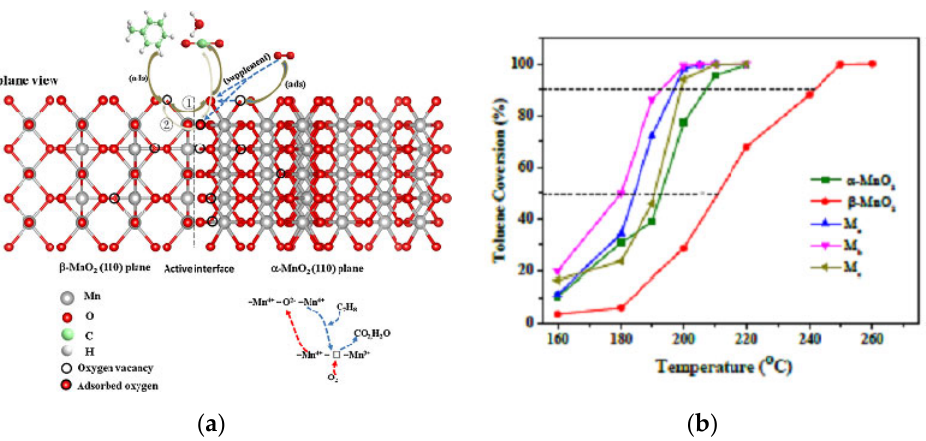
Figure 12. ( a ) Reaction scheme of toluene oxidation over α @ β‐ MnO 2 catalysts. ( b ) Activity profiles of the five samples for toluene oxidation as a function of temperature. Reprinted and adapted with permission from Ref. [98]. Copyright 2018 Elsevier.